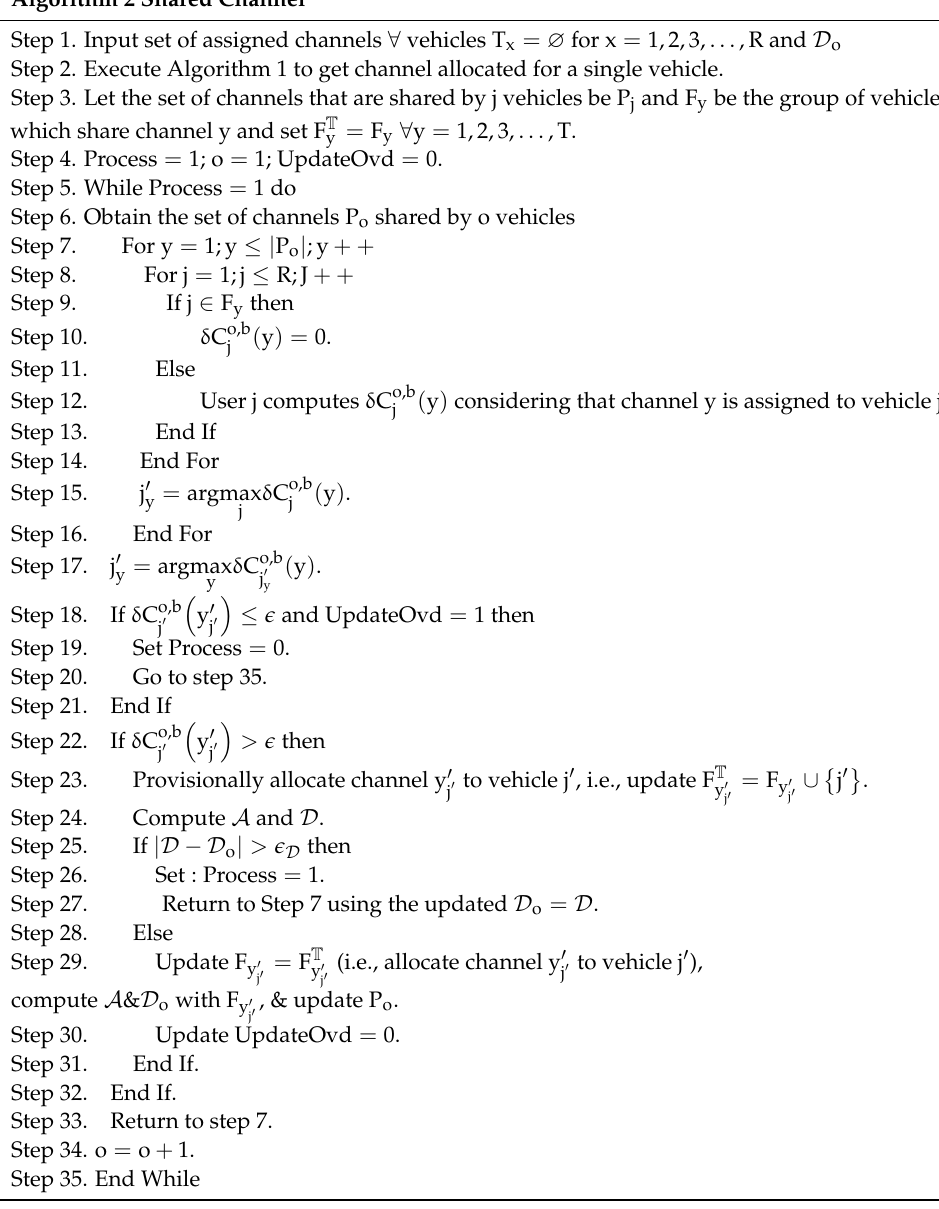
Algorithm 2 Shared